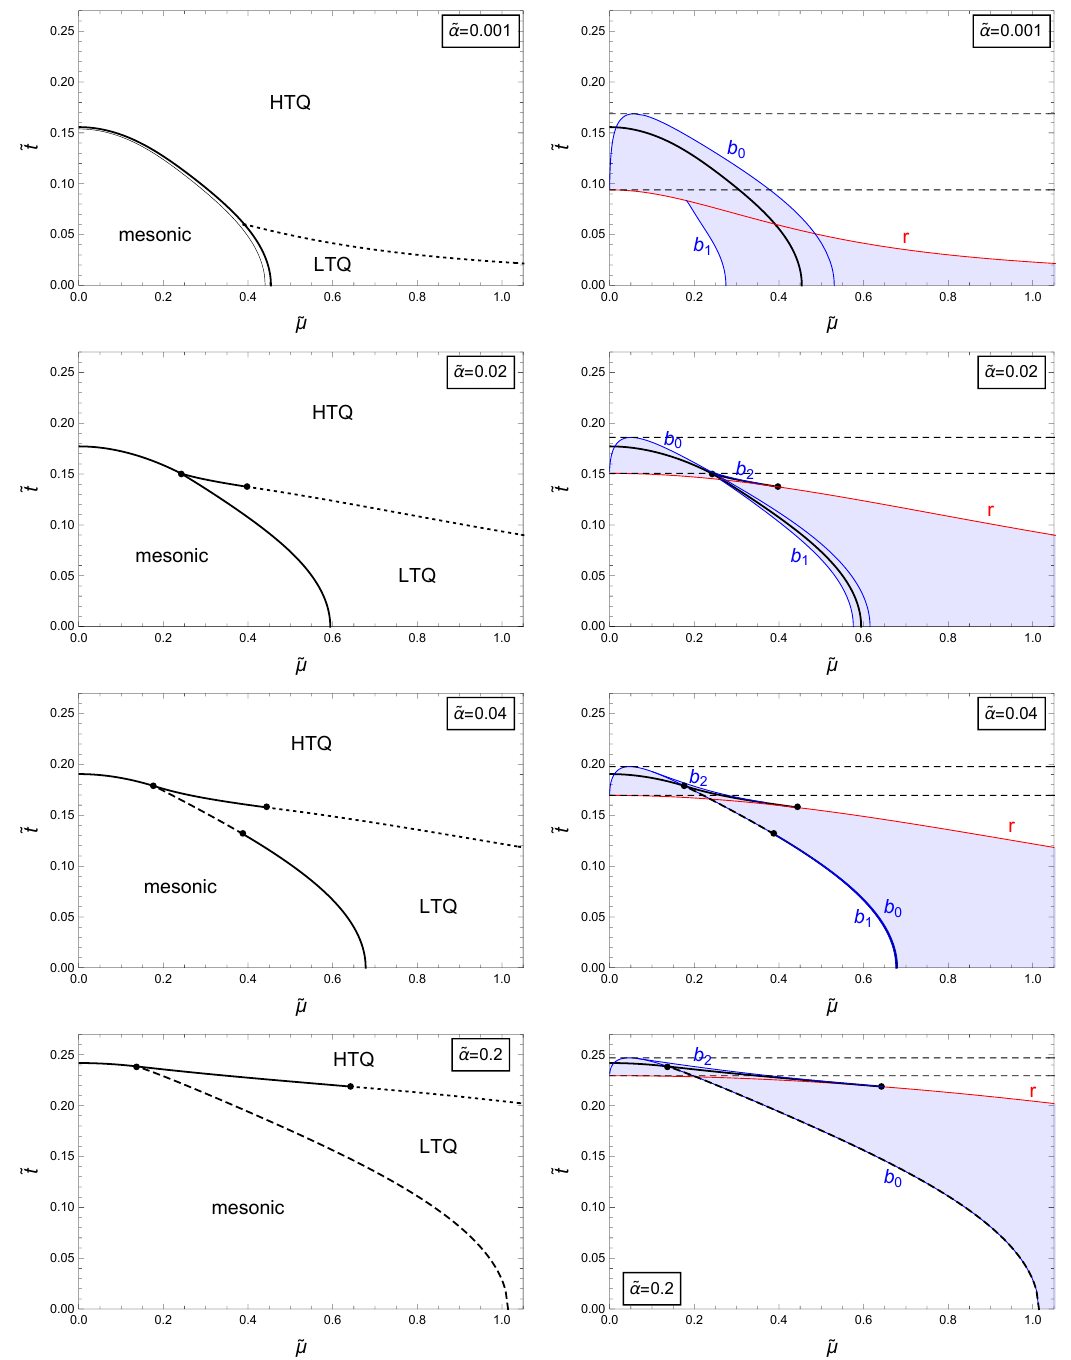
Figure 6 . Left panels: phase diagrams in the plane of dimensionless temperature ~ t and quark chemical potential ~ (cid:22) for increasing quark mass parameter ~ (cid:11) from top to bottom and (cid:12)xed coupling ~ (cid:21) = 15. Solid lines are discontinuous phase transitions, while transitions across dashed and dotted lines are continuous. The thin solid line in the upper left panel is the chiral phase transition in the massless limit. Right panels: same as left, but including curves that indicate regions of metastable and unstable solutions. For detailed explanations see text. The shaded region shows where the LTQ con(cid:12)guration